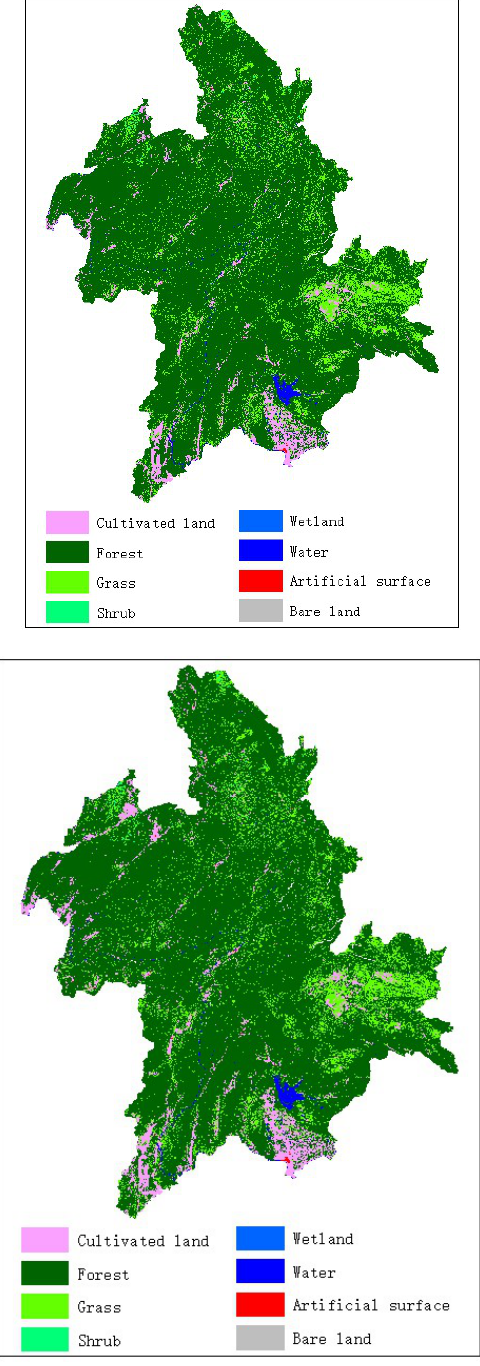
Fig. 4 GlobeLand 30 land cover maps in (a) 2000 and (b) 2010